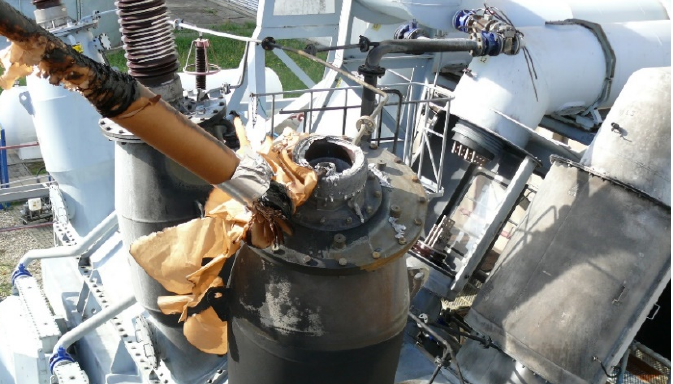
Figure 2. Example of a catastrophic failure of a transformer due to an explosion of an insulator bushing caused by internal PD.